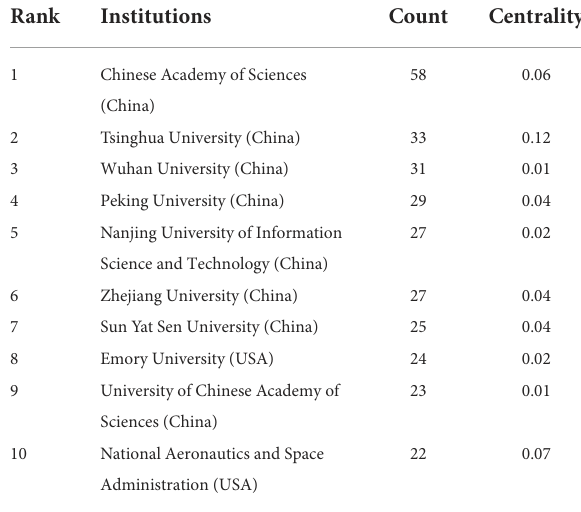
TABLE 2 The top 10 institutions publishing research on artificial intelligence and air